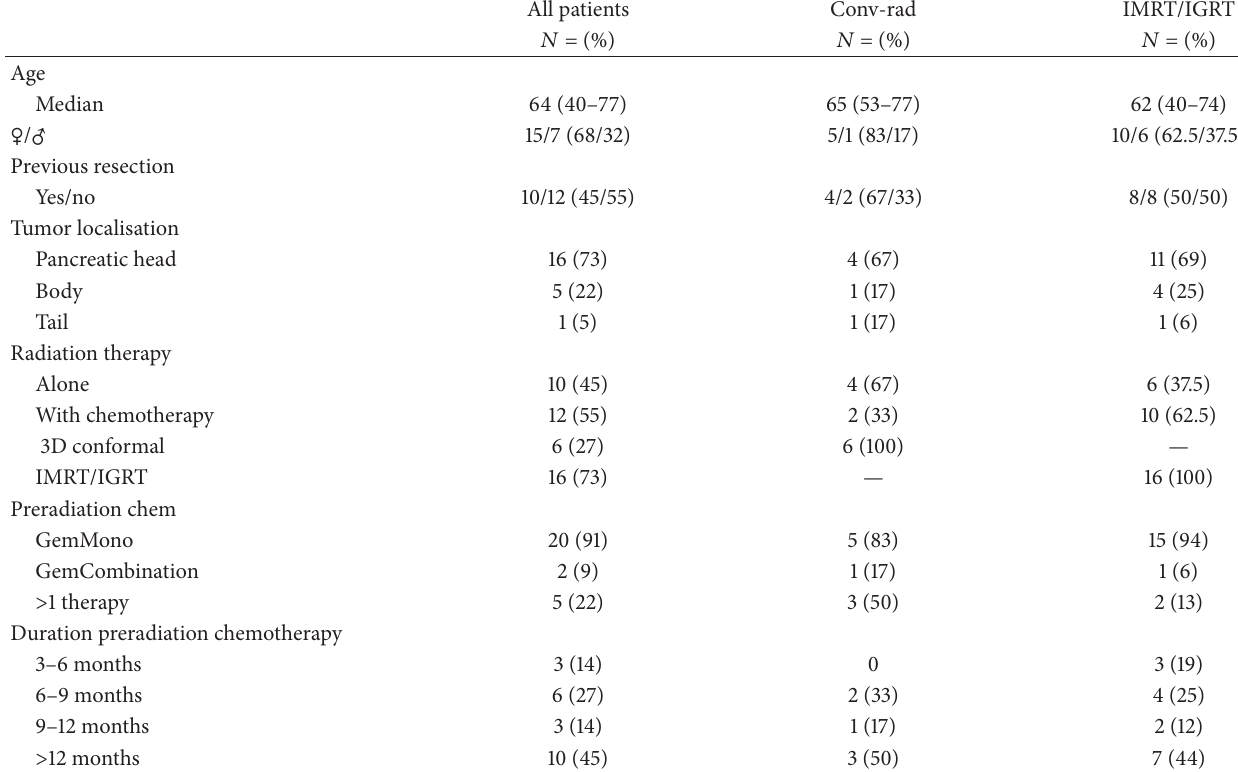
Table 1: Patient’s characteristics and treatment